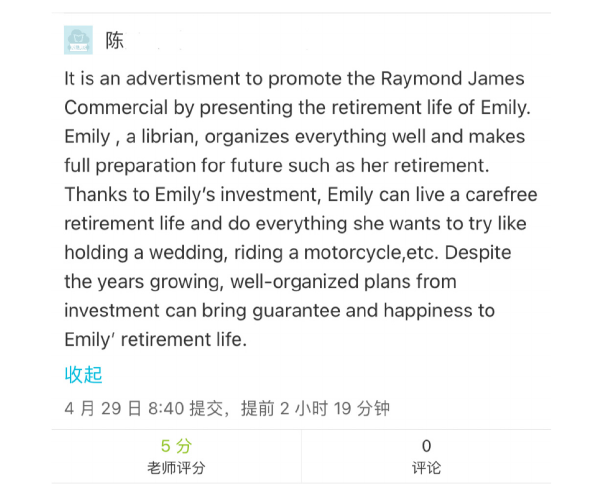
FIGURE 3 | An example of students’ completed work (week